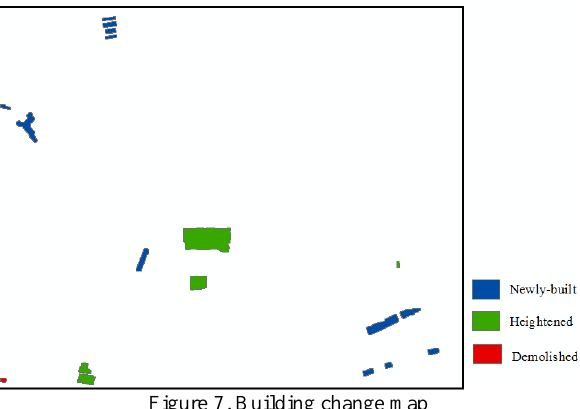
Figure 7. Building change map